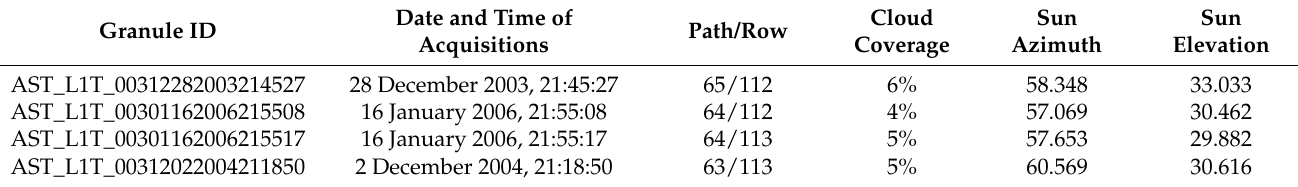
Table 2. The dataset attributes of ASTER images used in this